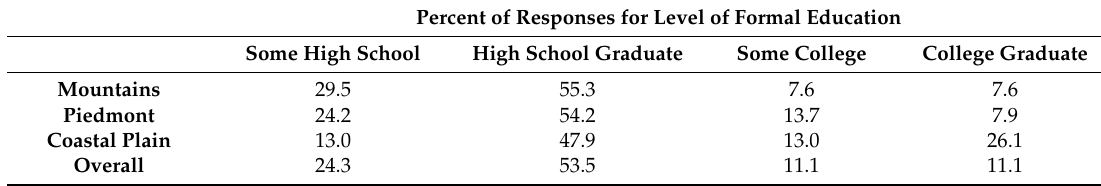
Table 1. Logging business owner education level by physiographic region.